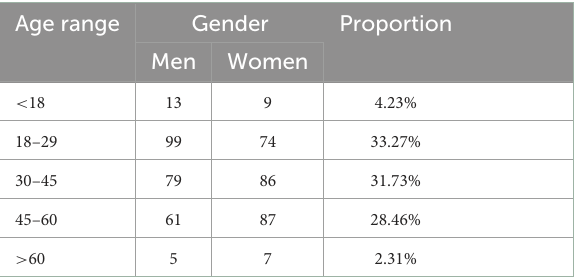
TABLE 2 Questionnaire participants’ gender and age